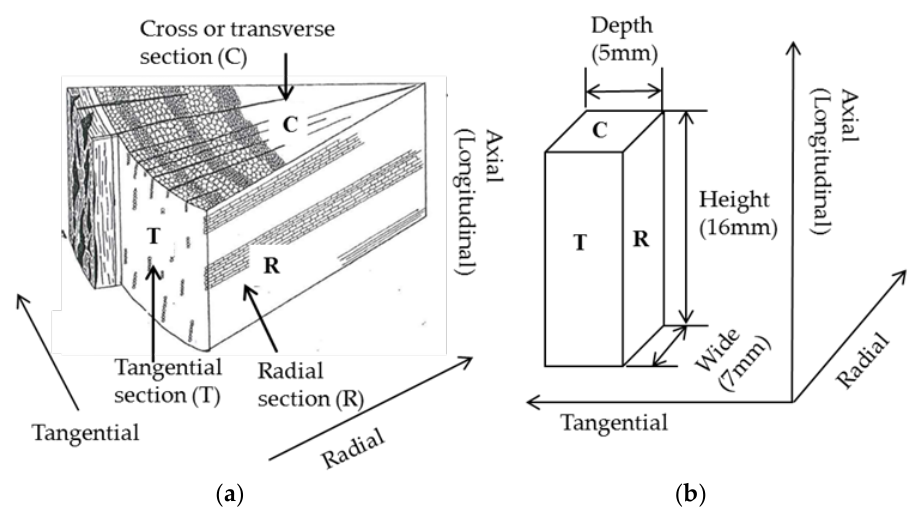
Figure 3. ( a ) Illustration of a section of wood showing the three planes discussed [39]; ( b ) Schematic of a wood sample used for these tests with the dimensions and orientations